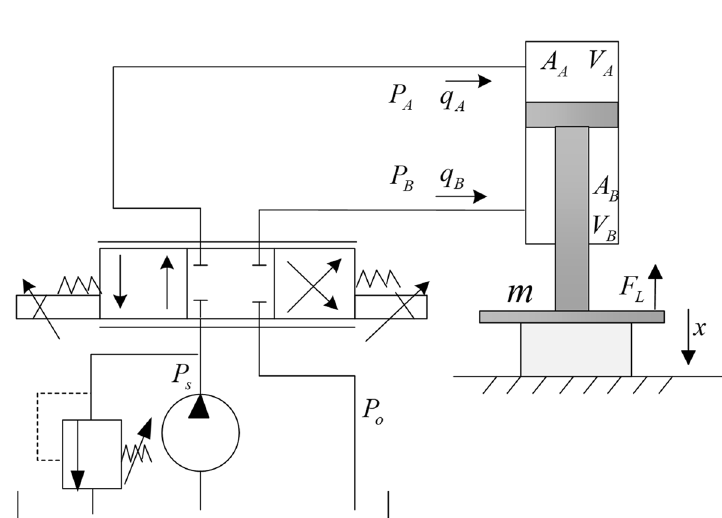
Fig. 1 Structure diagram of the valve-controlled electro-hydraulic